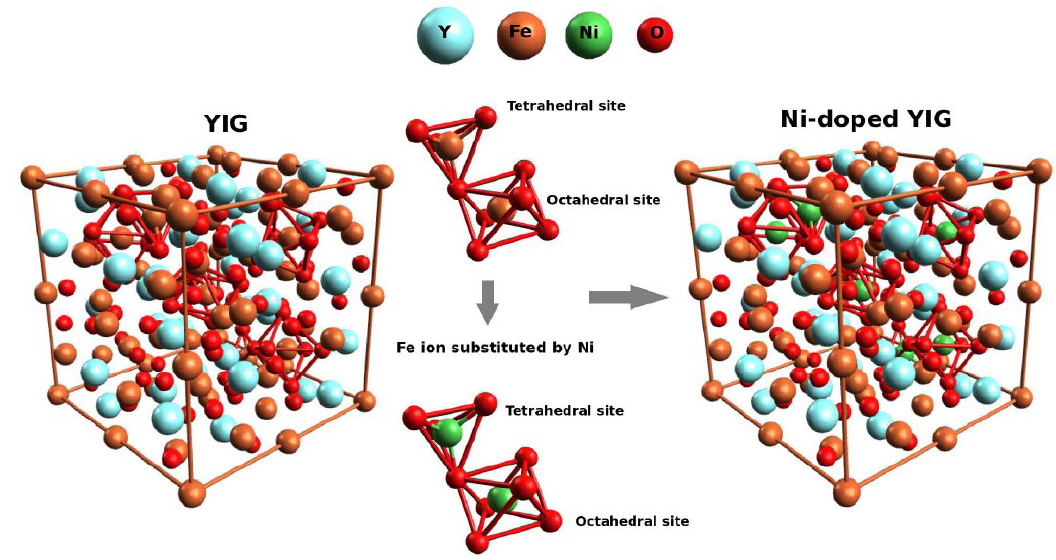
Figure 8. Illustration of the substitution of Fe and Ni atoms in the Tetrahedral and Octahedral Lattices 7